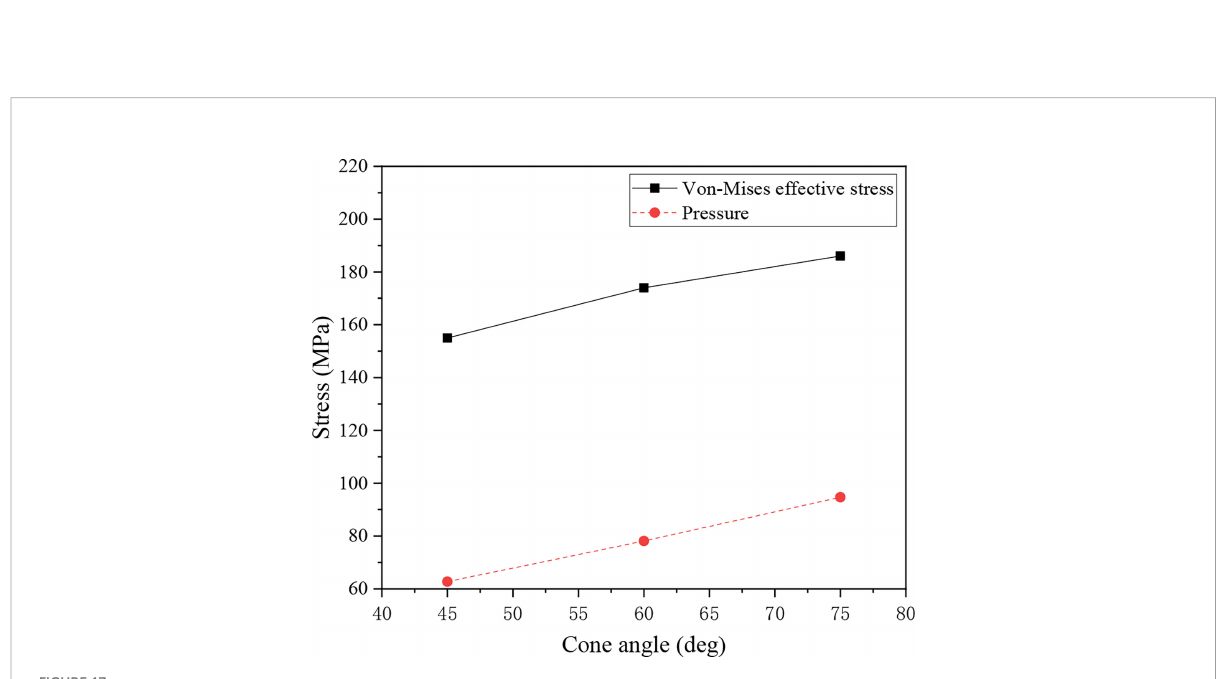
FIGURE 17 Maximum Von-Mises effective stress of pyramidal structures under different taper angles.